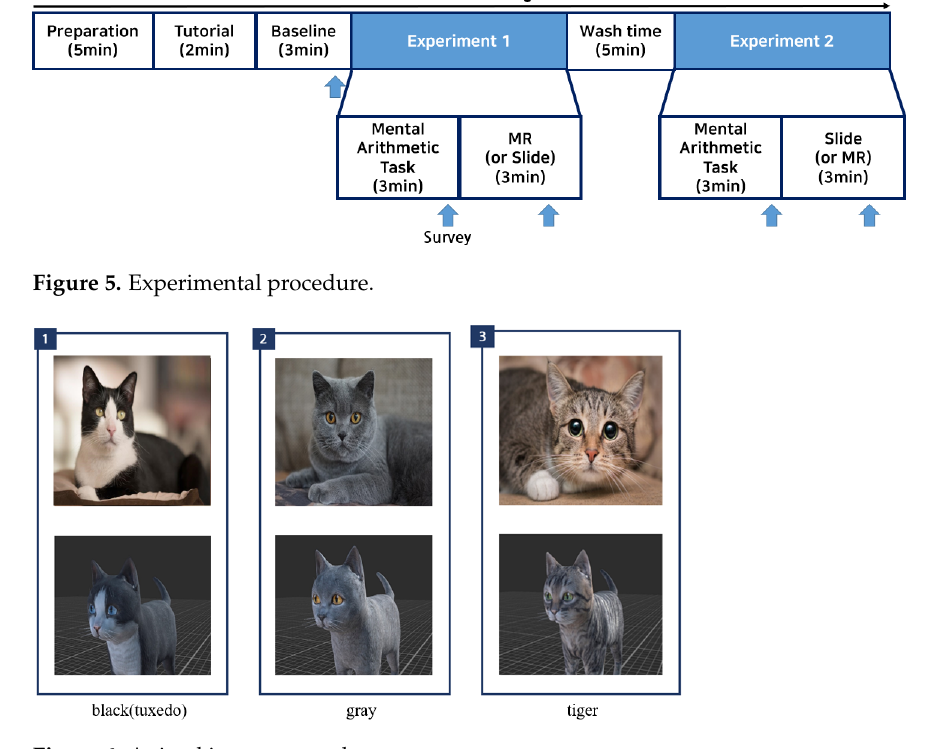
Figure 6. Animal image